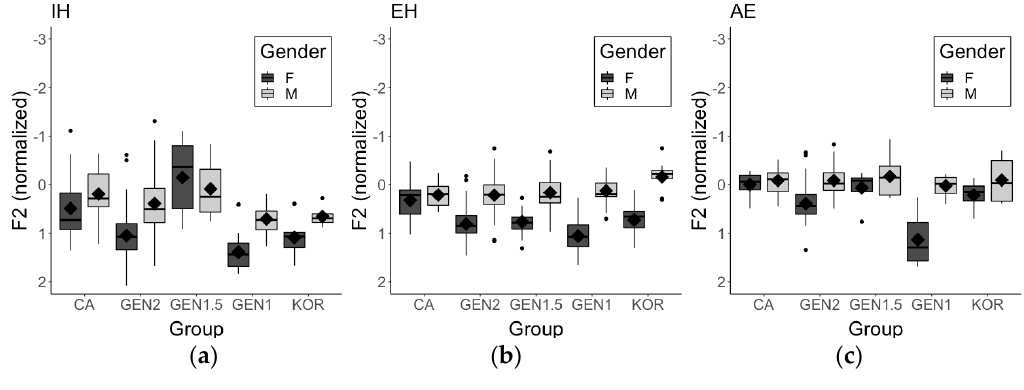
Figure 4. Normalized F2 across groups: ( a ) IH; ( b ) EH; ( c ) AE.